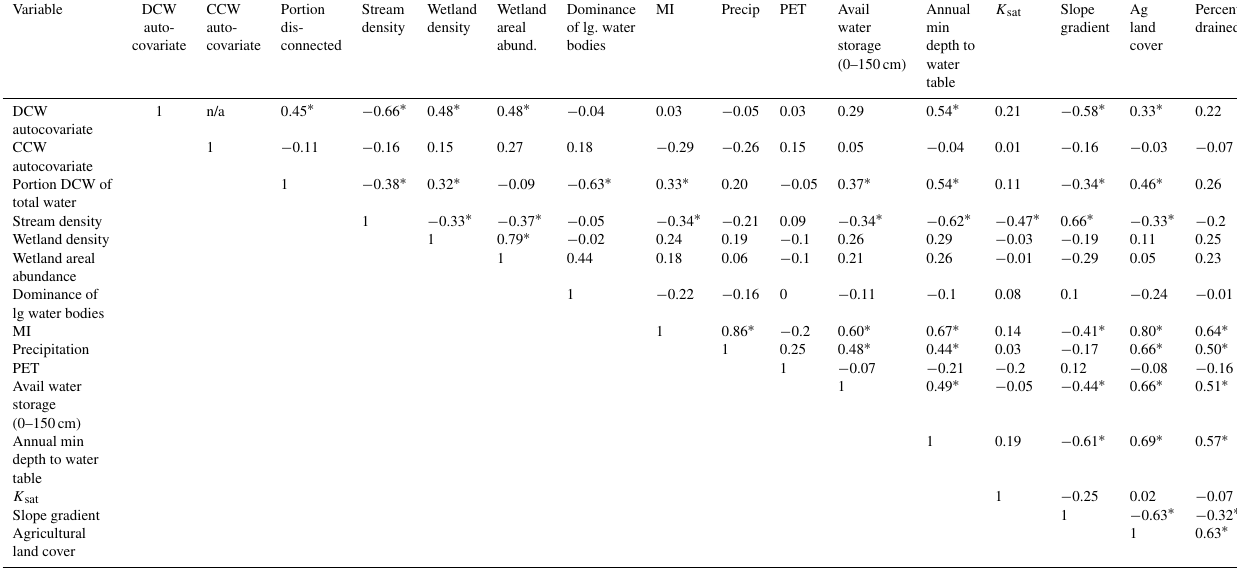
∗ Significant correlations ( p<